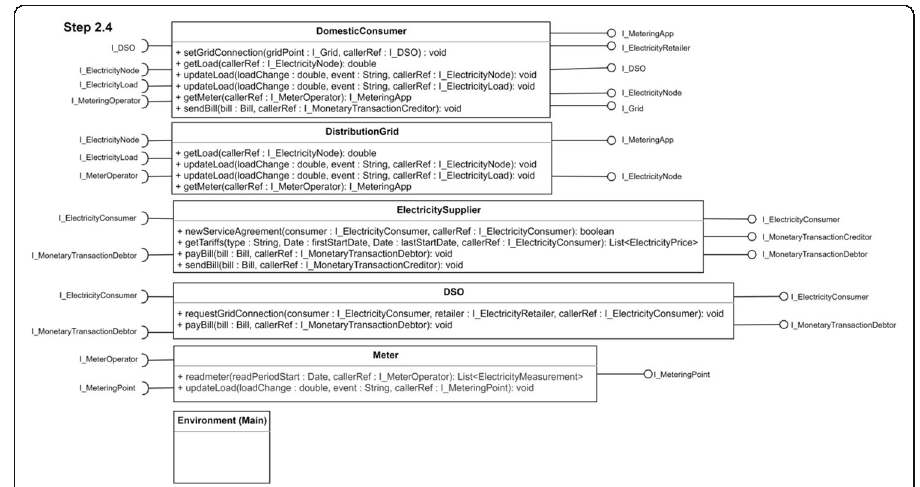
Fig. 8 Step 2.4 – Add reference elements for agent